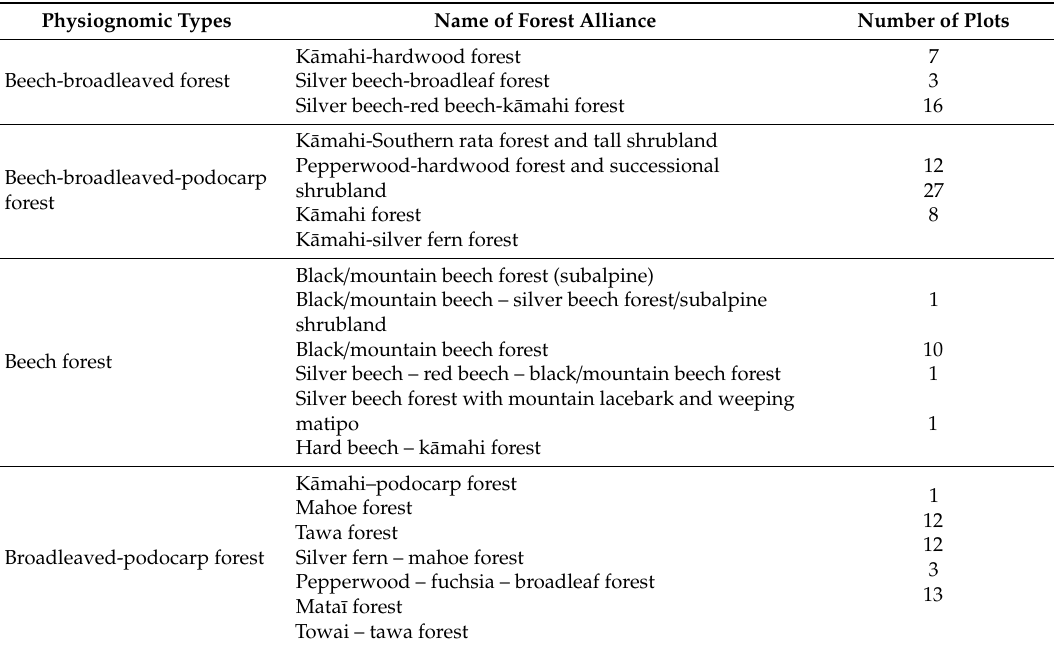
Table 5. Common forest alliances in the Wellington